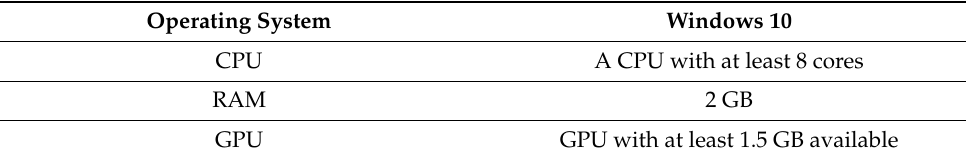
Table 2. Minimum requirement.